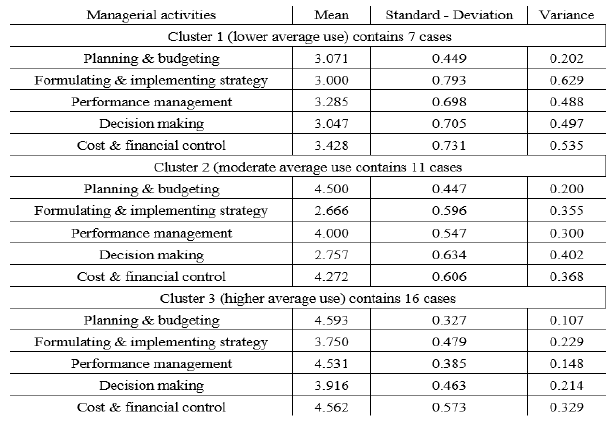
Table 2: The use of management accounting system information for the performance of the indicated activities – manager clusters in Romania